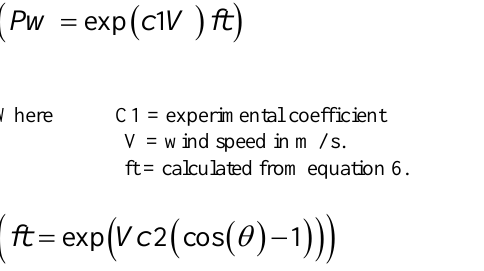
Figure 10. Central cell and its